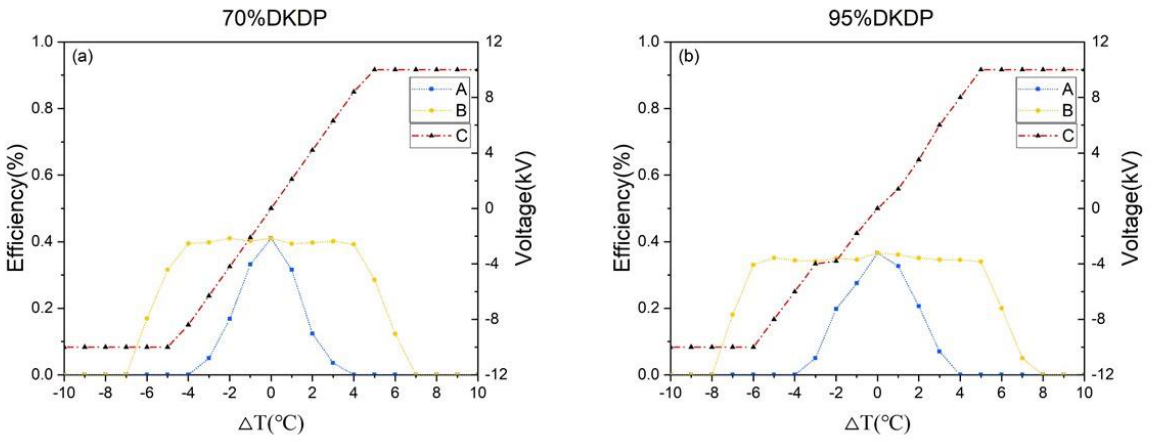
Figure 5. Experimental OPA efficiencies obtained via ( a ) 70%- and ( b ) 95%-deuterated DKDP versus temperature and compensation voltage. Line A represents the OPA efficiency without compensation, Line B indicates OPA efficiency where the phase mismatch is compensated, and Line C represents the compensation voltage.